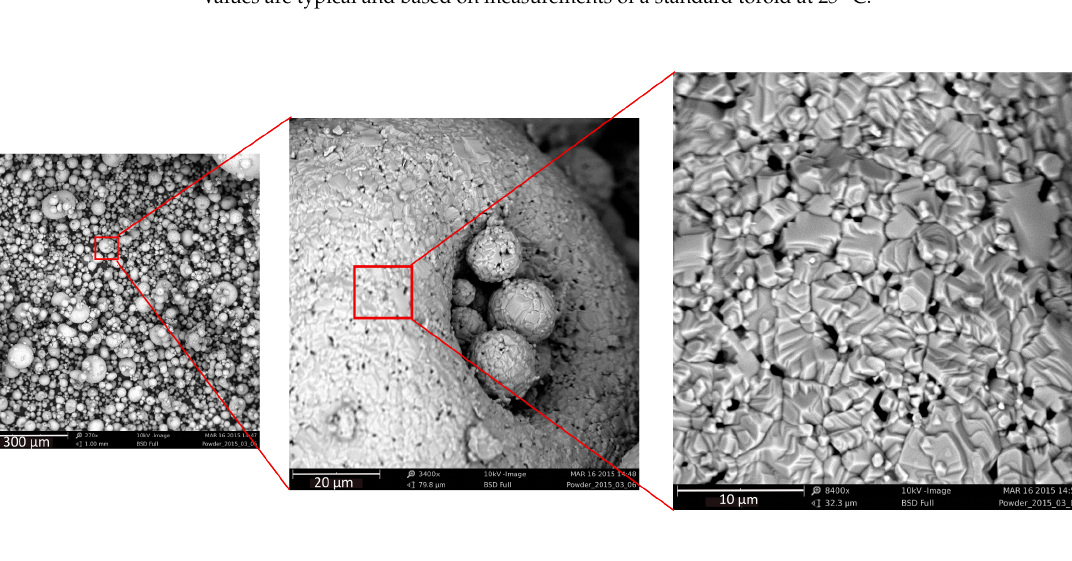
Figure 1. SEM images of NiFeZn soft magnetic powder. Due to the surface tension the particles stick to each other to form a spherical or a toroidal